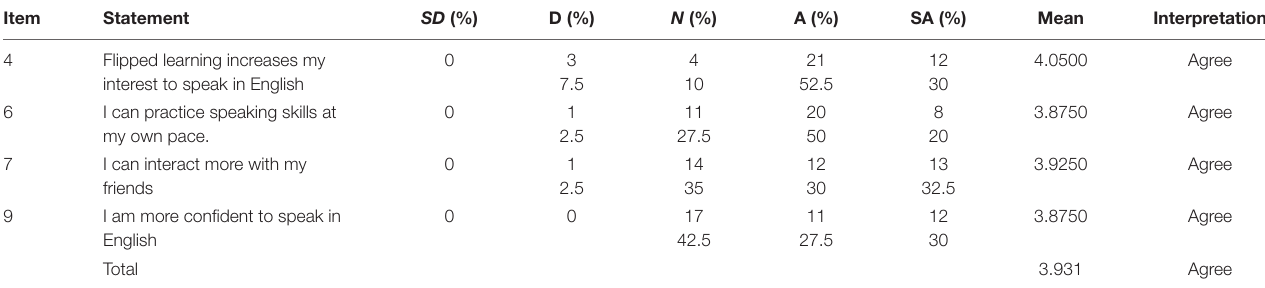
TABLE 5 | Mean score and standard deviation of the